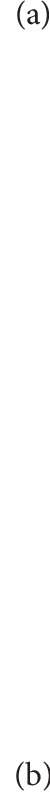
Posterior cranium exhibiting a large exophytic mass.